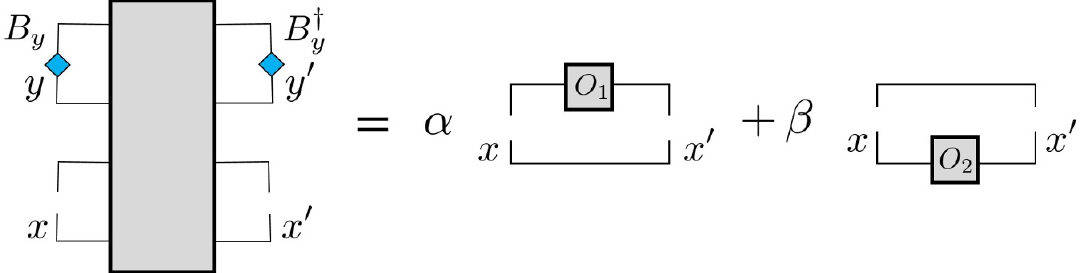
Figure 14 . If CI( x : y ) = 0, then the superdensity operator with (cid:12)xed y insertions can be written as a linear combination of a tensor network with a maximally mixed past, and a tensor network with a maximally mixed